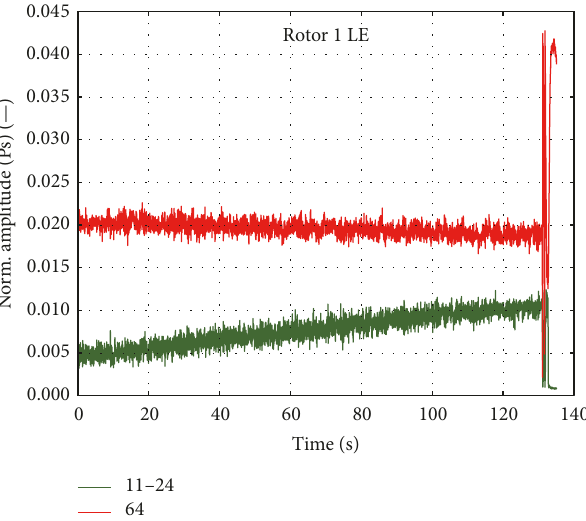
Figure 7: Temporal evolution of rotating instability modes (11 to 24) and rotor blade passing frequency during surge inception